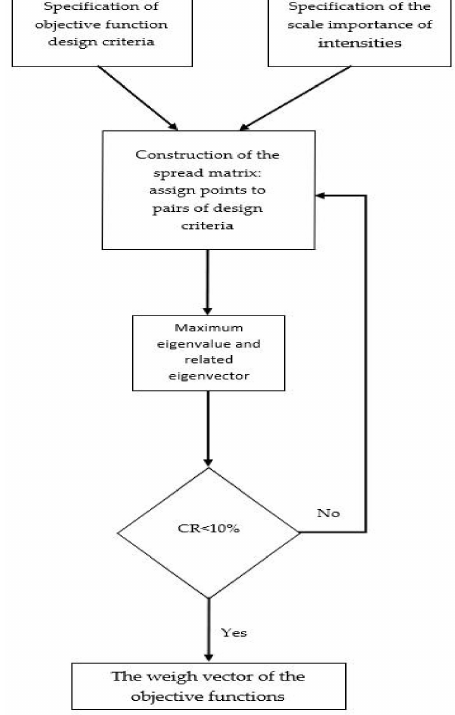
Figure 2. AHP flow diagram